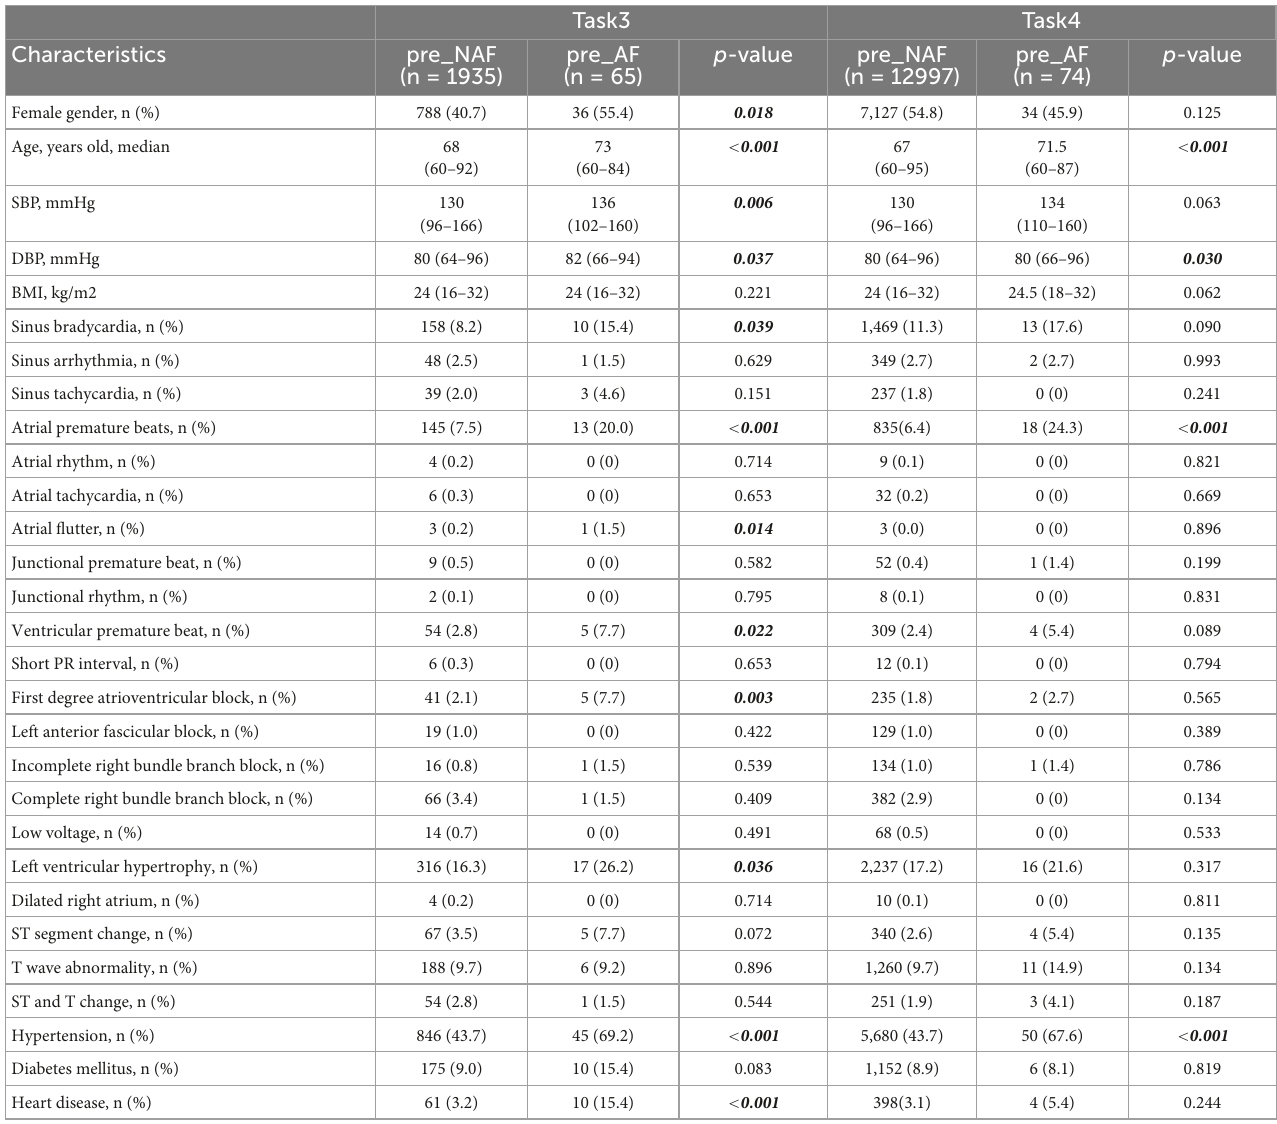
TABLE 4 Subjects characteristics at baseline in tasks 3 and 4.